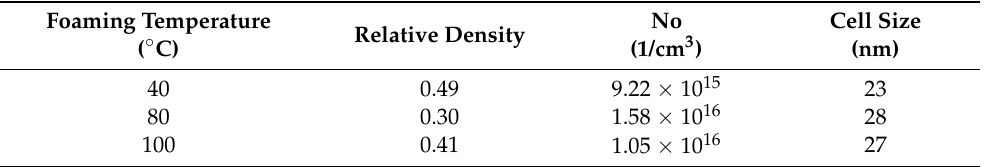
Table 1. Characteristics of nanocellular materials produced through a double cycle with different foaming temperatures in the second cycle. First cycle parameters 20 MPa − 32 ◦ C foamed at 60 ◦ C for 1 min and second cycle parameters 31 MPa 24 ◦